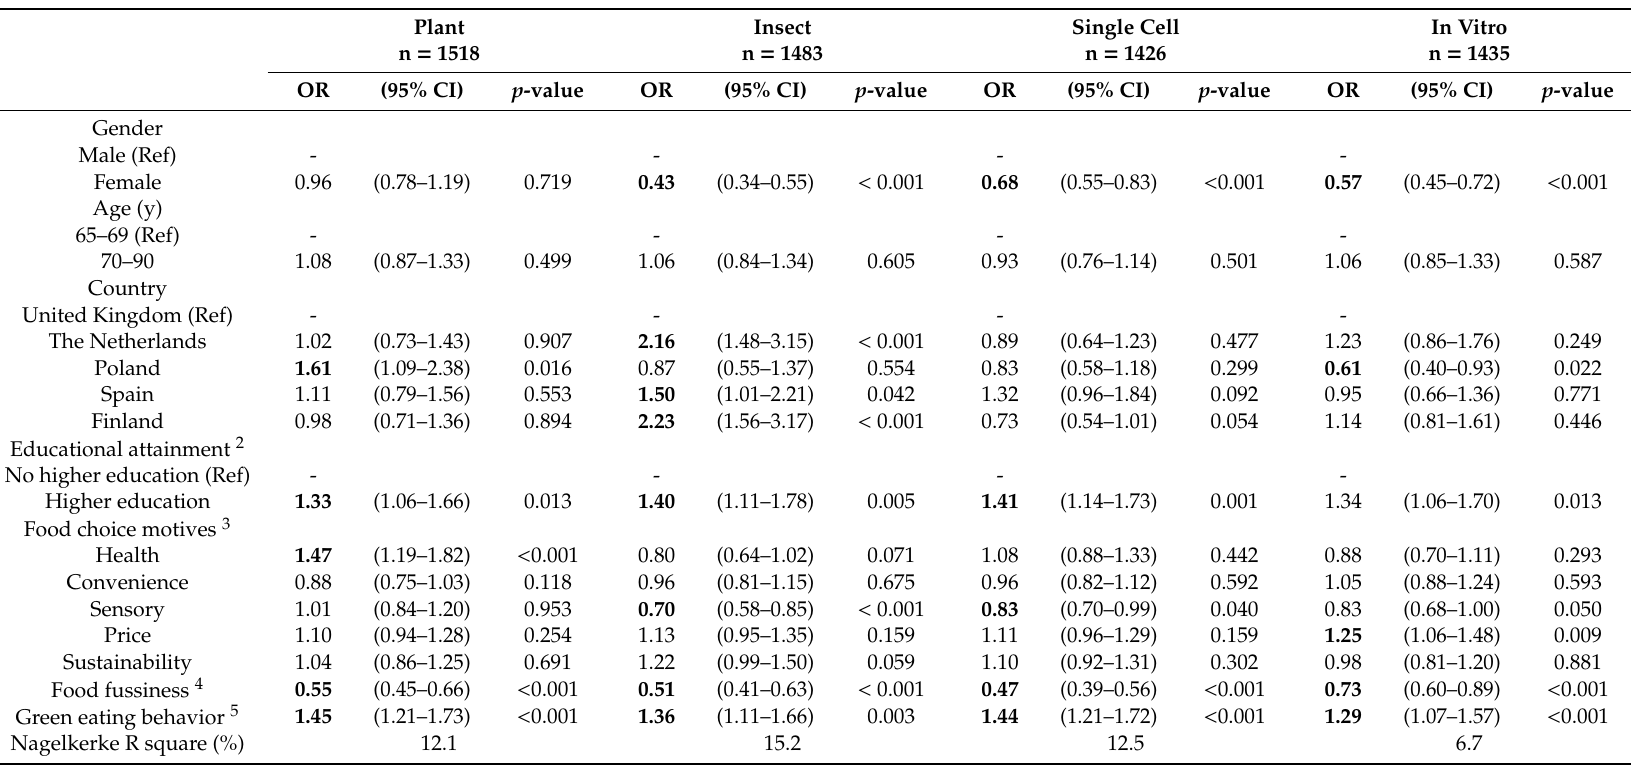
Table 2. Determinants of acceptance to eat food products containing protein from alternative, more sustainable sources in adults aged 65 years and older from five EU countries—results from ordinal regression analyses 1